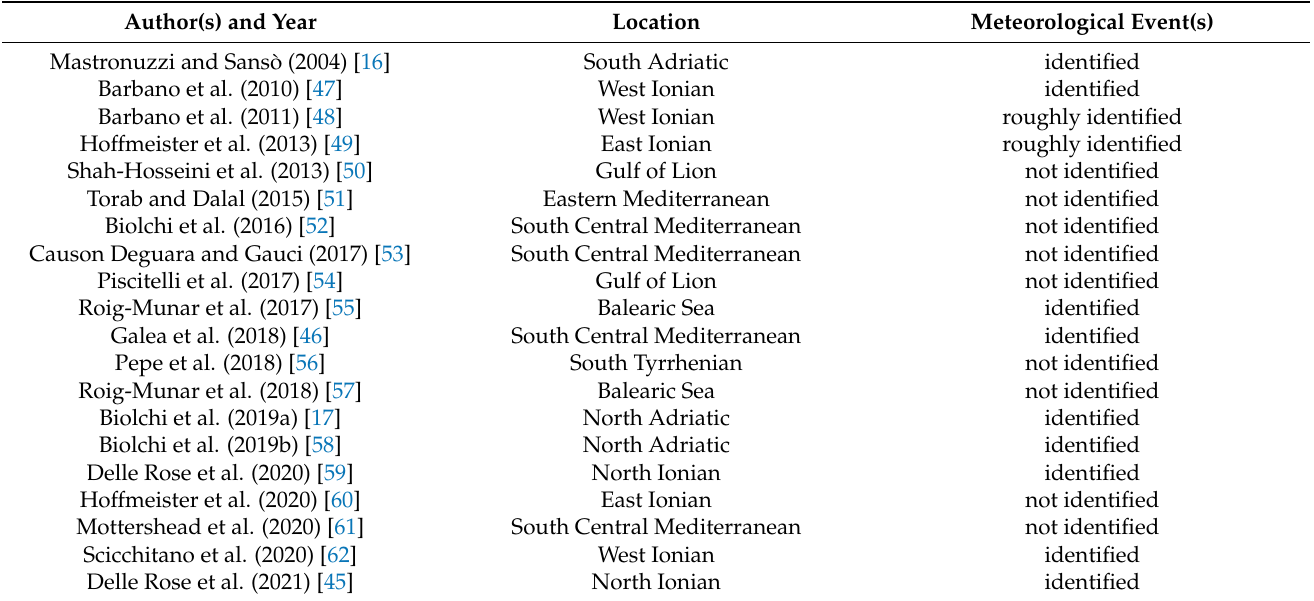
Table 1. Summary of reviewed articles.